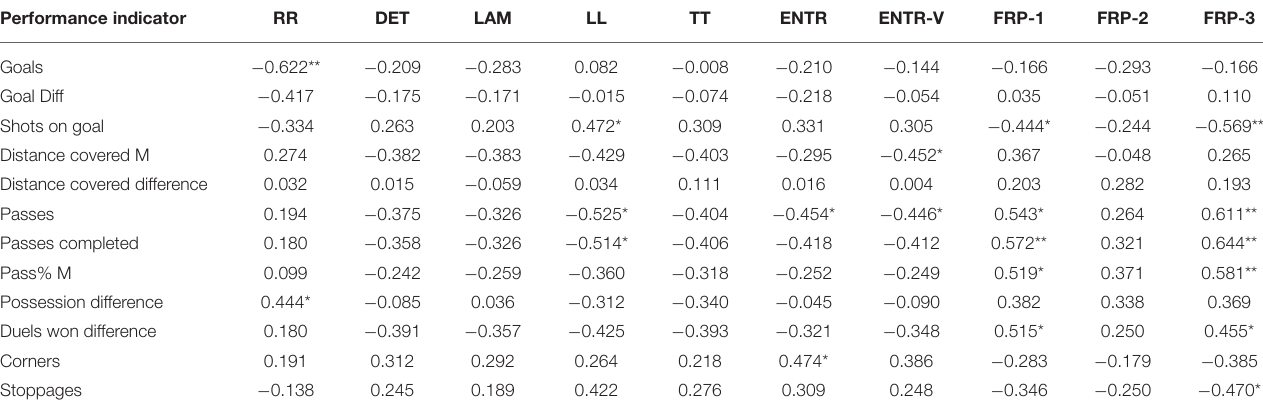
TABLE 4 | Inter-correlations between the recurrence parameters and the traditional PIs for n = 21 matches (*significant correlations; **highly significant correlations). Performance